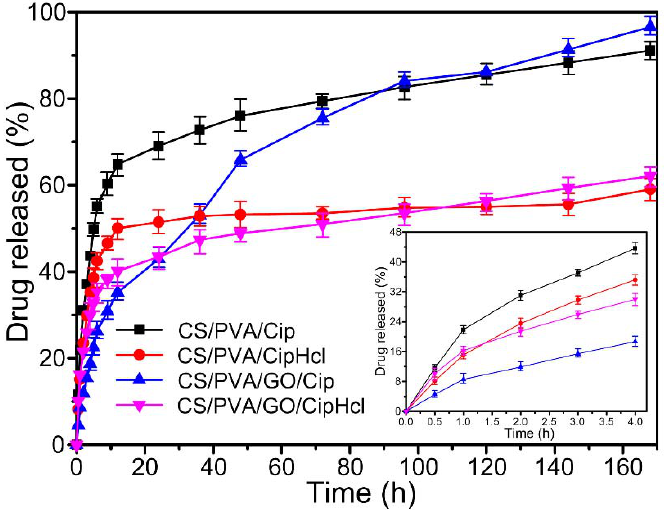
Figure 7. In vitro drug release curves of drug-loaded nanofibrous membranes.